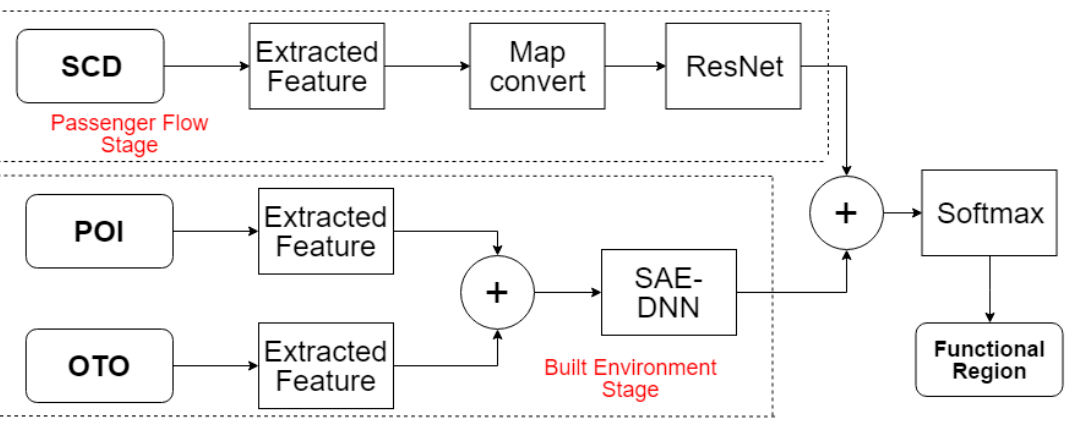
Figure 1. The overall framework.